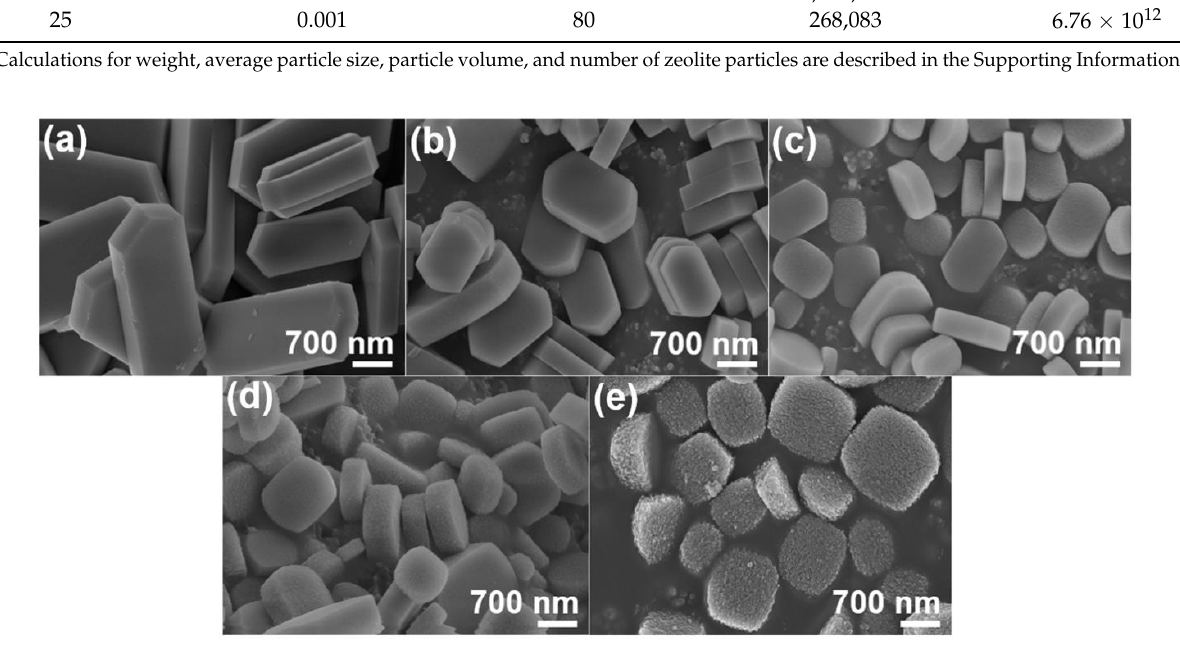
Figure 1. Zeolite growth without silicalite-1 seed crystals. SEM imagery of the Al-ZSM-5 crystal samples with ( a ) SAR = ∞; ( b ) SAR = 140; ( c ) SAR = 70; ( d ) SAR = 40; and ( e ) SAR = 35. The synthesis was conducted at 150 °C for 3 d under different sol compositions: 4050 H 2 O:4.5 TPAOH:20 SiO 2 :x Al 2 O 3 :2x NaOH, where x was dependent on the SAR.